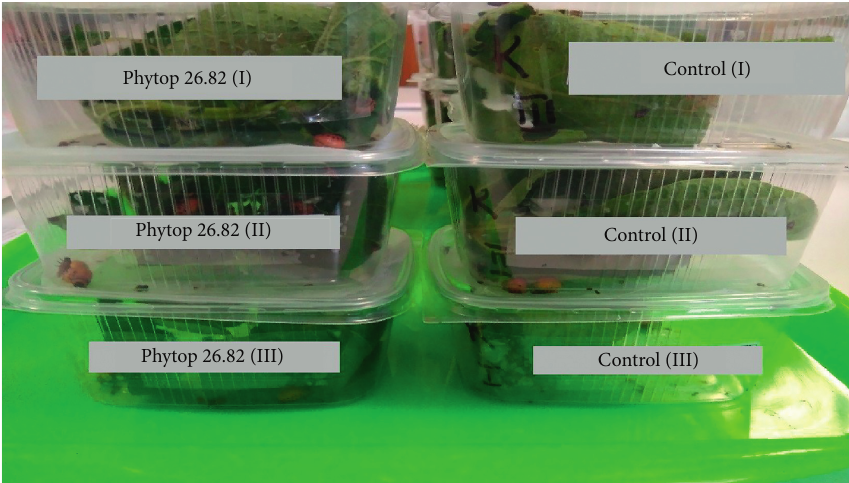
Figure 1: Laboratory experience in evaluating the insecticidal activity of Phytop 26.82. Table 2: The fungicidal effect of bioagents on potatoes of the “Kemerovchanin” variety by the counting week. Experience variants